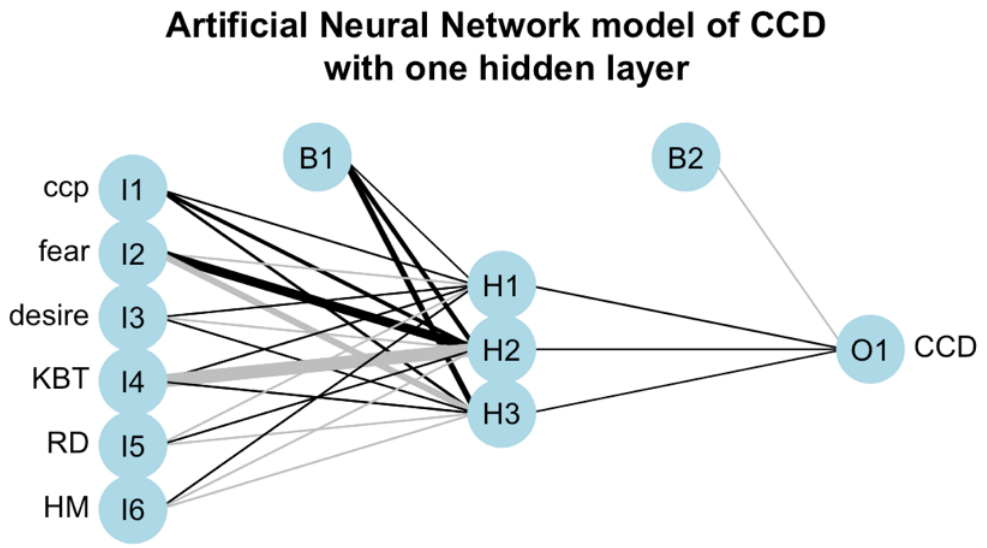
Figure 2. The neural network interpretation diagram of the ANN model with one hidden layer of the numbers of CCDs at the simulation end.